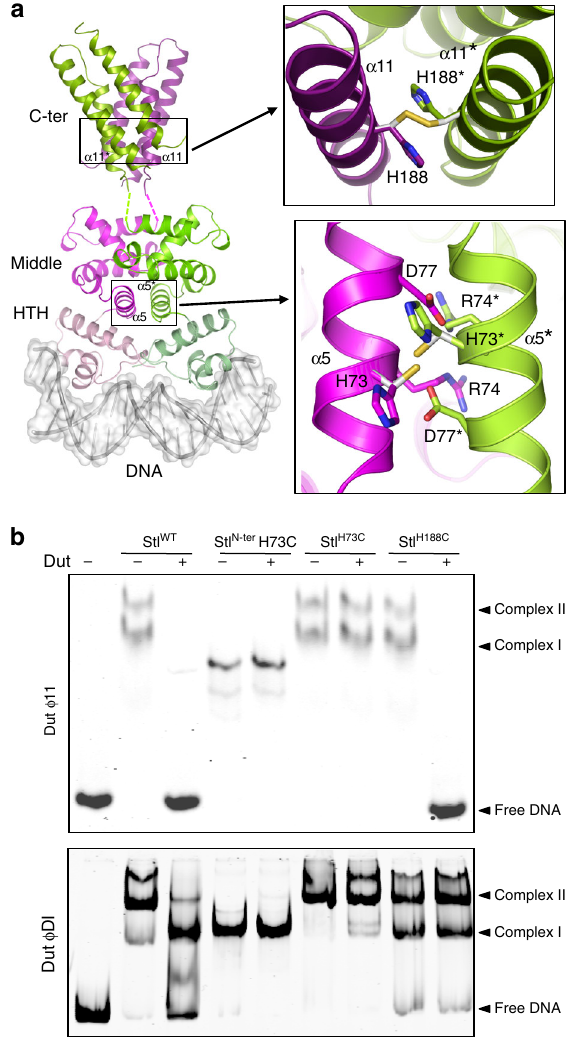
Fig. 7 Stl dimerization and Dut interaction. a Localization of site-speci fi c crosslinks designed based on the dimer model of Stl. (left) A model of dimeric, full-length Stl bound to DNA was generated from BovI-Stl N-ter and BovI-Stl C-ter structures using the structure of C.Esp1396I-DNA complex as a template (PDB:3CLC). The Stl model is represented in cartoon, coloured in different tones of magenta for one protomer and green for the other. The tones are light, medium and dark for the HTH, middle and C-terminal domains, respectively. The DNA is represented in surface. The cysteines introduced to induce crosslinking are shown as sticks and coloured, with carbons in white and sulfurs in yellow. b EMSA experiments show that the Stl dimers stabilized by H73C or H188C disul fi de bonds bind to the SaPIbovI Stl promoter similarly to the wild-type protein. However, these covalent dimers, but not the wild-type protein, are resistant to the DNA dissociation induced by dimeric Dut ϕ DI, while only the Stl dimer mediated by H73C bonds is resistant to the dissociation induced by the trimeric Dut ϕ 11.